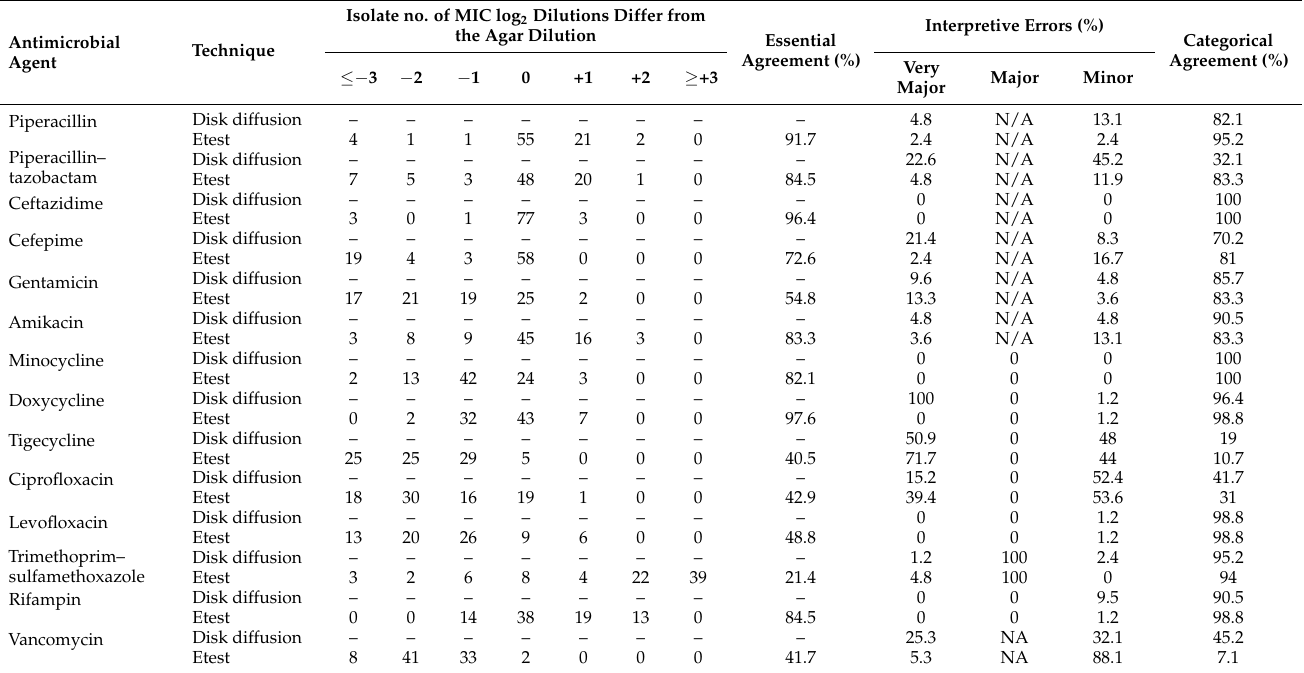
Table 3. Comparison of the disk diffusion and Etest methods with the agar dilution method for antimicrobial susceptibility testing of 84 E. anophelis